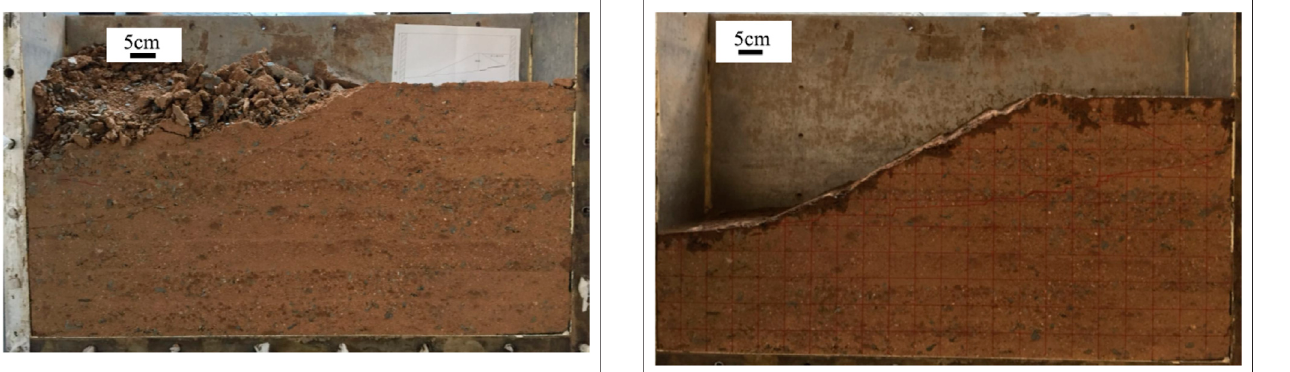
FIGURE 7 | Model of HRF embankment (after